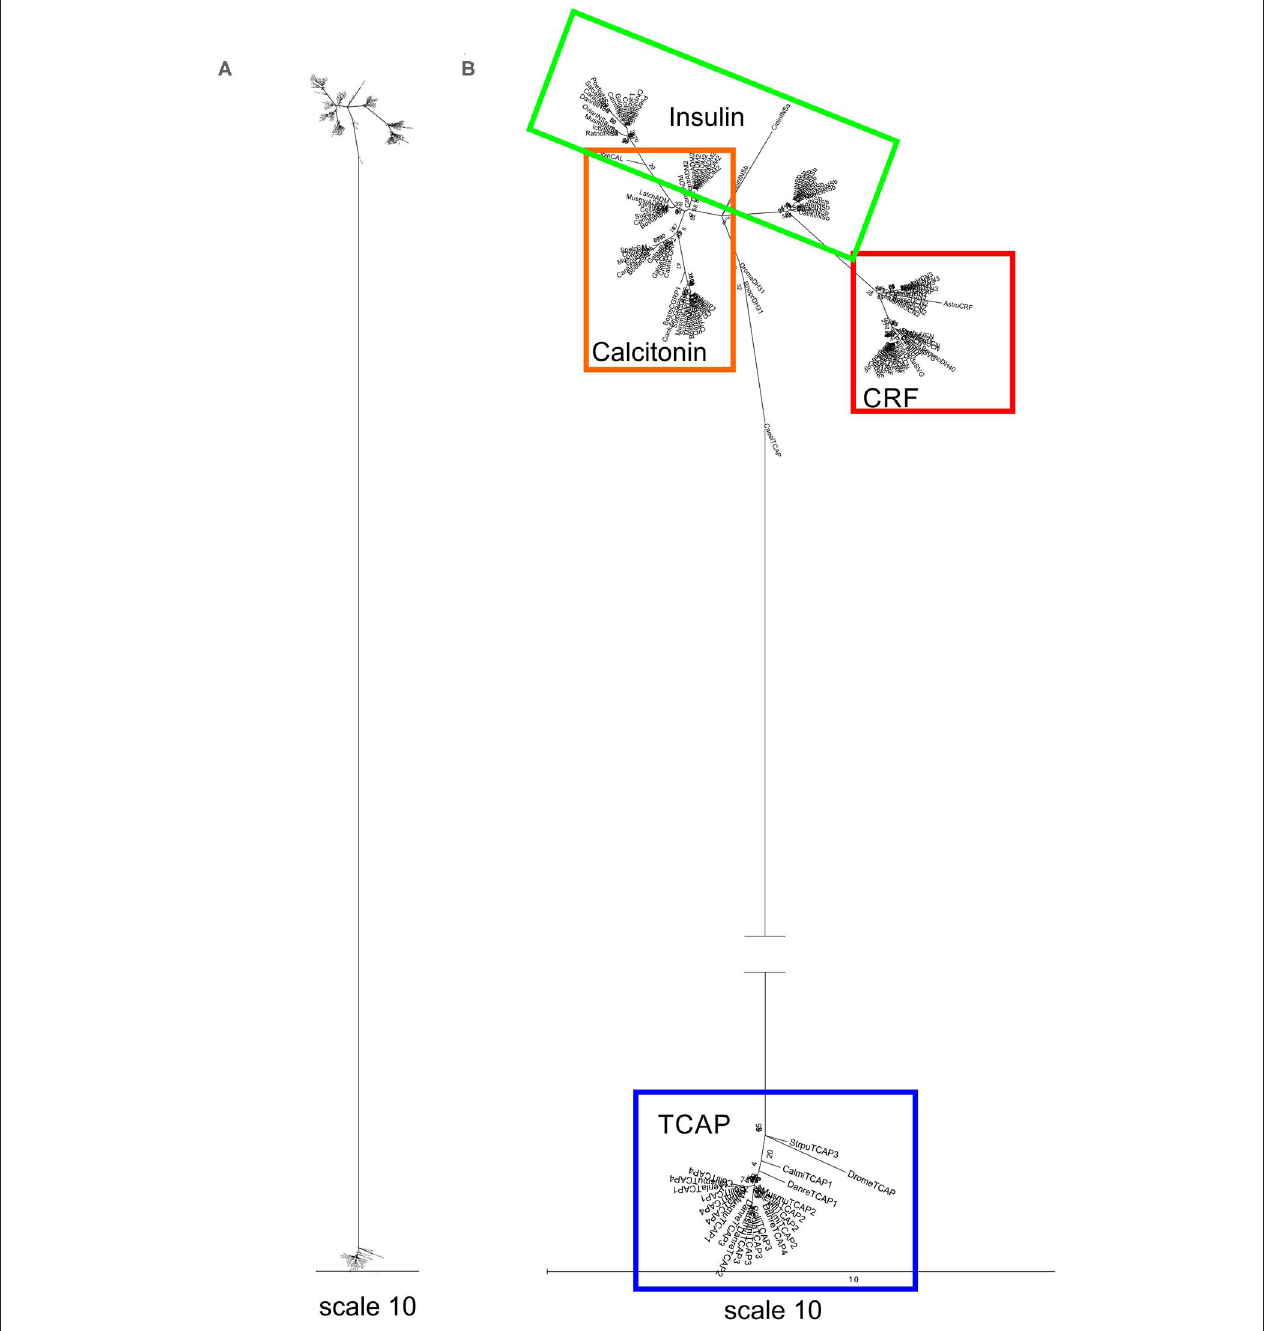
FIGURE 5 | Phylogenetic analysis of insulin, calcitonin, CRF and TCAP mature peptides (rooted to TCAP). The trees are represented as (A) original tree with the appropriate scale (B) magnified and rooted to TCAP. Each family is highlighted with a different color: CRF (red), calcitonin (orange), insulin (green), TCAP (blue). Analysis was conducted using the maximum likelihood method based on the Dayhoff matrix-based model (lnL = − 1019.5552; + G, parameter = 6.6766) (41). Initial trees for the heuristic search were obtained by applying the NJ method to a matrix of pairwise distances estimated using a JTT model. Branch lengths represent the number of substitutions per site, with the tree shown to scale. Bootstrap analysis involved 1,000 replicates. Calcitonin family: CALC, calcitonin; CGRP1, calcitonin-gene-related peptide 1; CGRP2, calcitonin-gene-related peptide 2; AM, amylin; ADM, adrenomedullin; ADM2, adrenomedullin 2; Insulin: INSa, insulin A chain; INSb, insulin B chain; CRF family: CRF, corticotropin-releasing factor; TCN, teleocortin; UCN, urocortin; UCN2, urocortin 2; UCN3, urocortin 3; UI, urotensin; SVG, sauvagine; DH, diuretic hormone; Outgroup: TCAP, teneurin C-terminal associated peptide. The scale bar indicates the level of magnification for the tree.